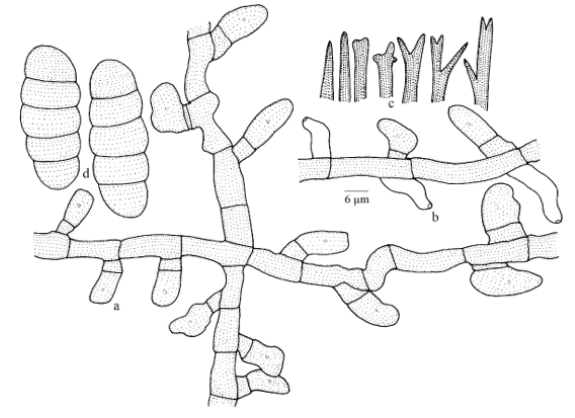
Figure 64. Meliola citricola a - Appressorium; b - Phialide; c - Apical portion of mycelial setae;